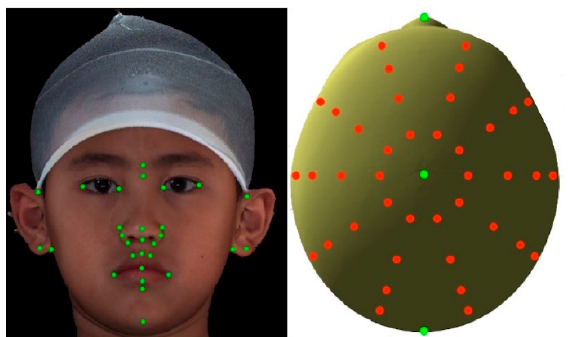
Figure 1. Three-dimensional images displaying (left) 32 manually-placed landmarks (green) on recognizable anatomy structures and (right) additional 40 digitally constructed landmarks (red) from top view.